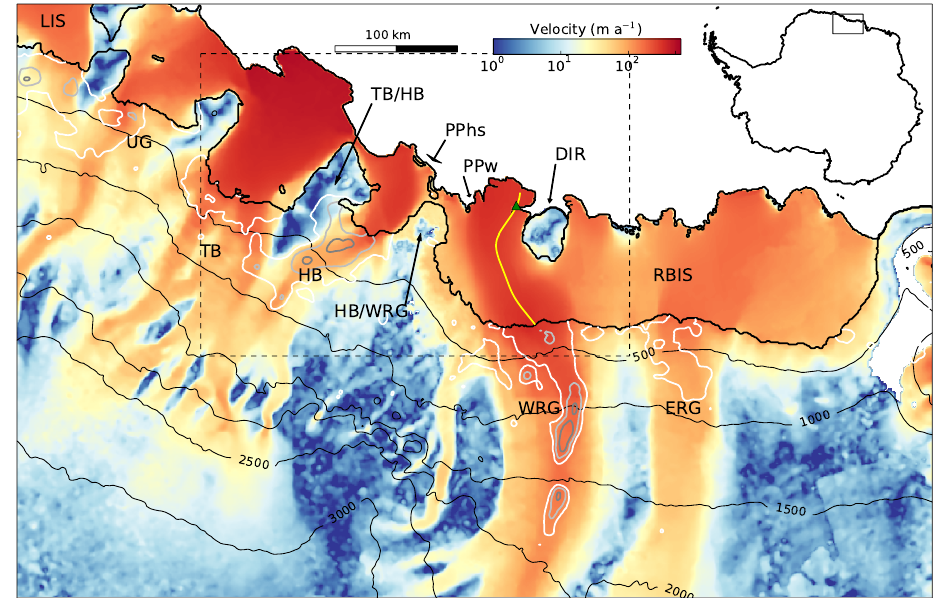
Figure 1. Computational domain with the extended flow field from Berger et al. (2016) in the background. The thick black lines show the grounding line and the calving front. The thin black lines show ice surface elevation contours every 500m. The white, light grey, and dark grey lines are bed elevation contours of − 500, − 750, and − 1000m, respectively. The yellow line shows the central trench of the bathymetry excavation (Sect. 2.1), and the green triangle the supporting bathymetric data (K. Leonard, personal communication, 2012). The dashed box shows the domain of interest shown from Figs. 2 to 7 and in Figs. S2 the Supplement. LIS: Lazarev Ice Shelf; UG: unnamed